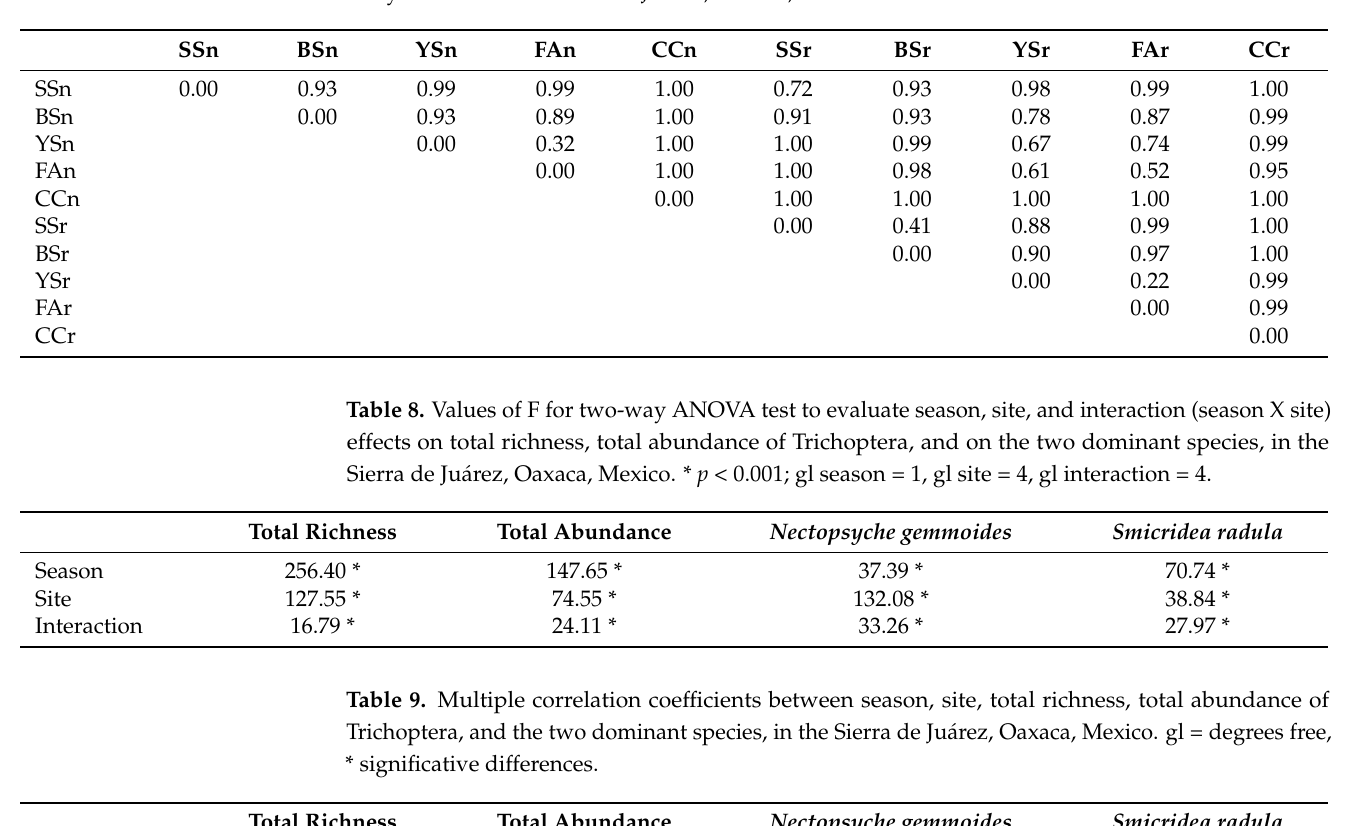
Table 7. Values of total beta diversity between Trichoptera assemblages and between “nortes” and rainy seasons in the Sierra de Ju á rez, Oaxaca, Mexico.